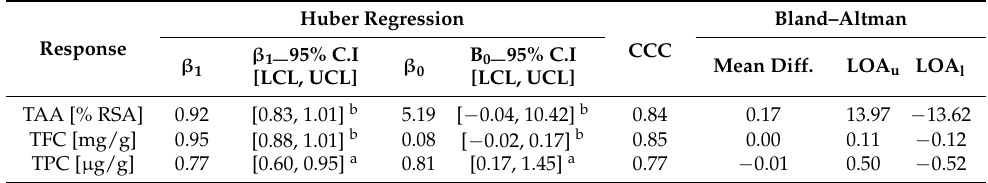
Table 6. Method comparison metrics chemical attributes.